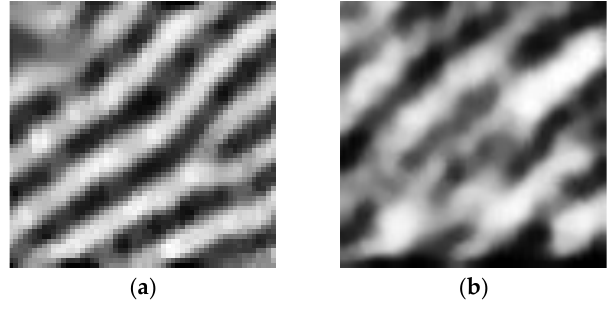
Figure 3. Fingerprint images for different sensing distances. ( a ) Image for a 250-μm-thick passivation layer; ( b ) Image for a 300-μm-thick passivation layer.